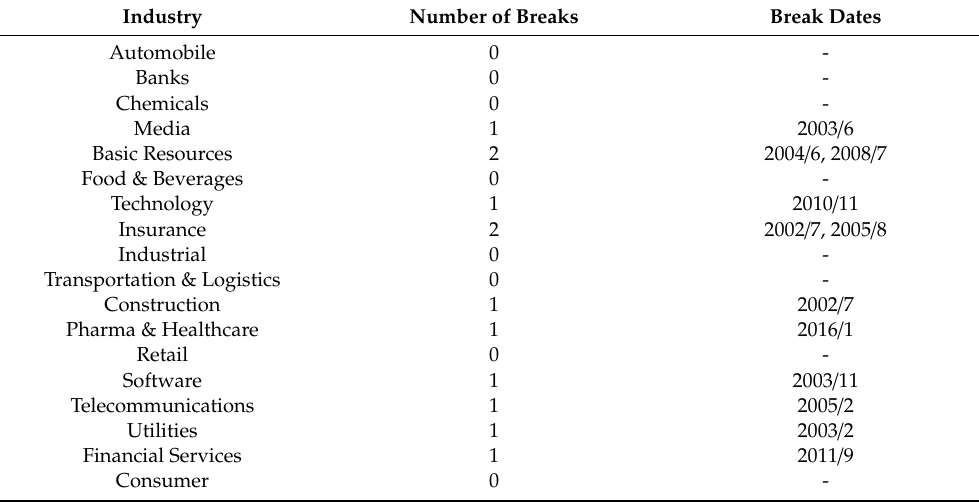
Table 4. Testing for structural change—the single factor